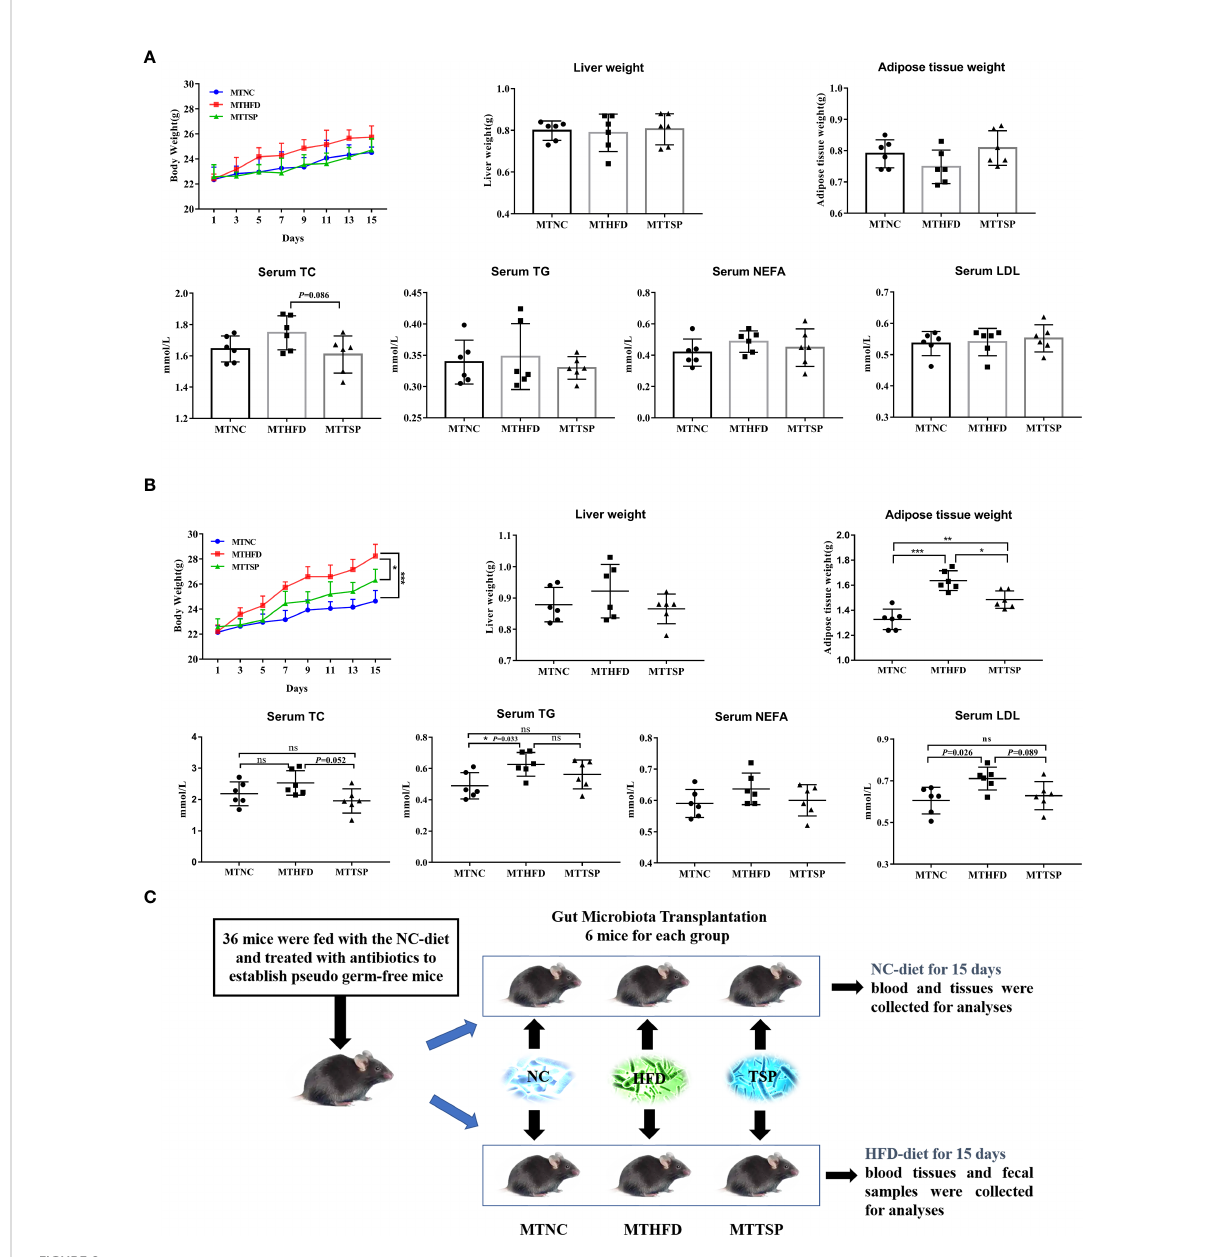
FIGURE 9 Microbiota Transplantation from TSP- supplementation Mice Exerts an Anti-Obese Effect in HFD-Fed Mice. (A) Microbiota-transplanted mice fed with NC-diet; (B) microbiota-transplanted mice fed with HFD-diet; (C) The experiment design of microbiota transplantation. Data are presented as mean ± SEM, differences were denoted as follows: * p < 0.05, ** p < 0.01, *** p < 0.001; ns, no signi fi cant p >